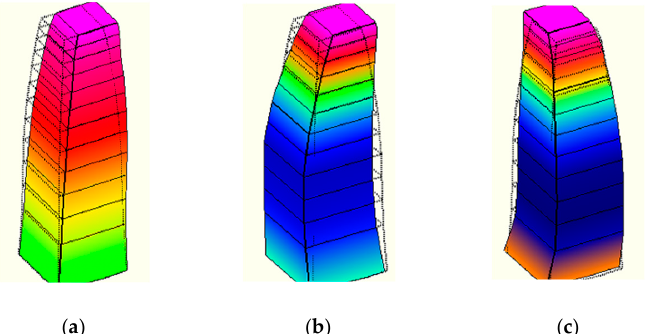
Figure 15. Mode modal diagram of the Small Wild Goose Pagoda. ( a ) First-level mode. ( b ) Second- level mode. ( c ) Third-level mode. (Note: the color change of each mode only indicates the amplitude change of that mode.)